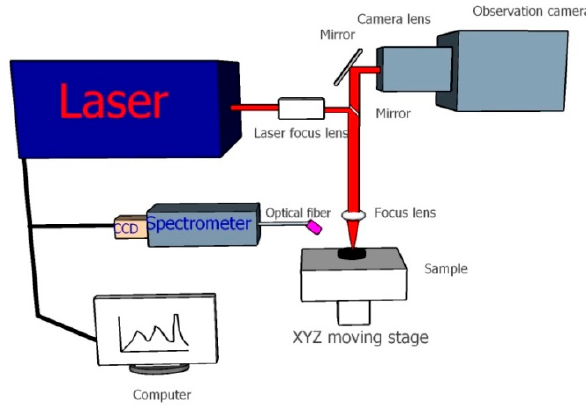
Figure 4. Schematic diagram of the laser-induced breakdown spectroscopy (LIBS) system.